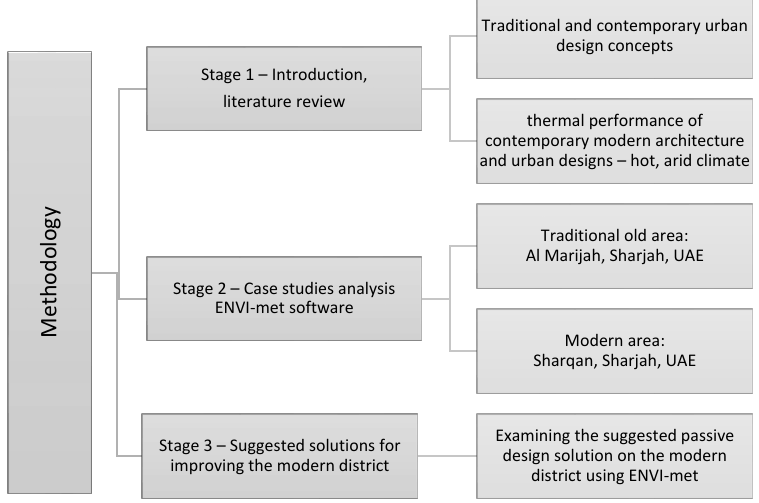
Figure 1. Research methodology outline.